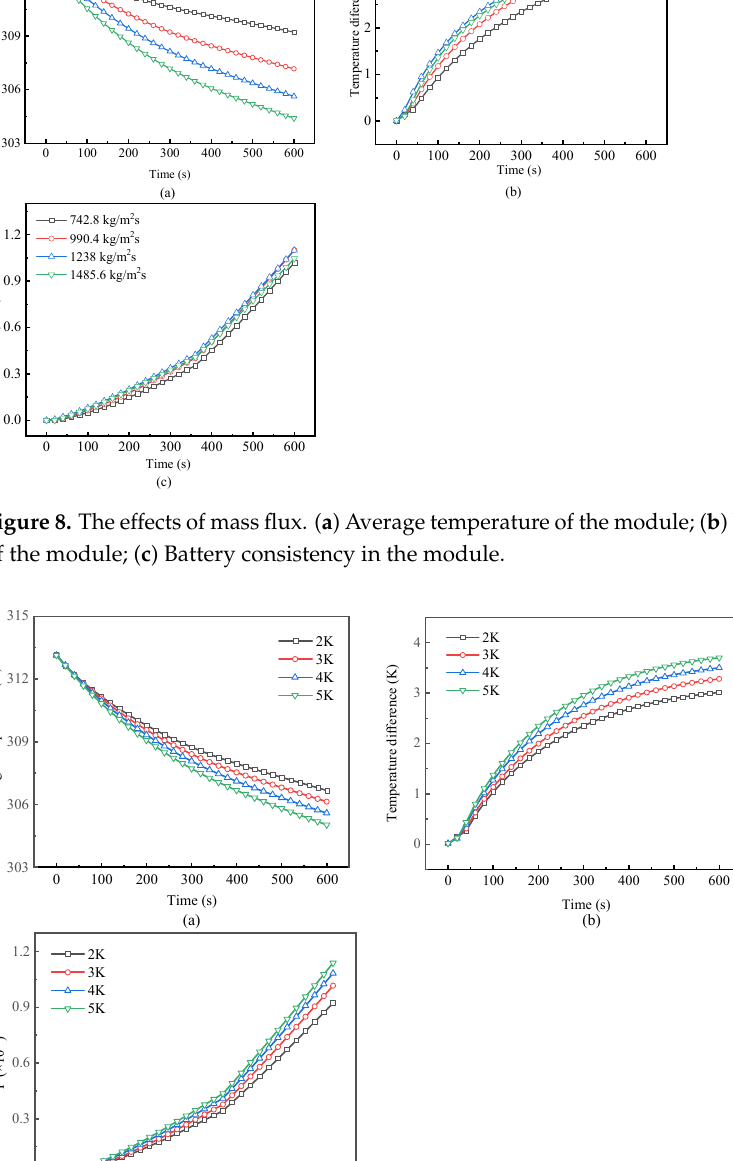
Fig. 9. The effects of subcooling degree (a) Average temperature of the module; (b) Temperature uniformity of the module; (c) Battery consistency in the module.